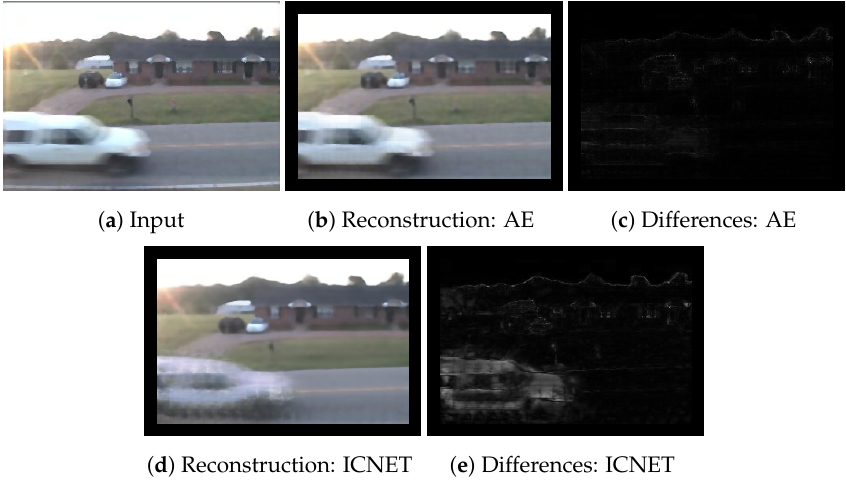
Figure 8. Comparison of reconstruction performances. The reconstructed image from ICNET ( d ) has a larger number of differences in the foreground region than AE ( b ). These larger differences lead to a larger recall in ICNET-ED, as shown in Figure